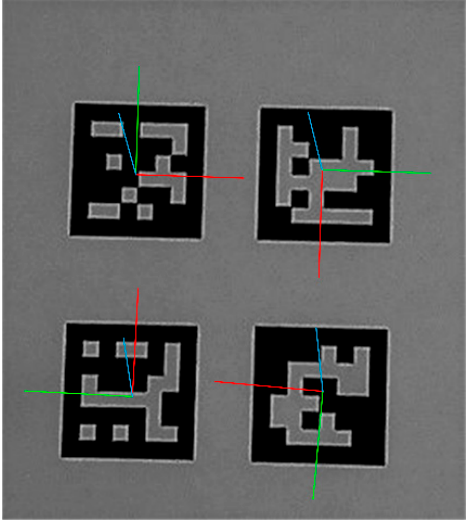
Figure 22. ArUco markers close range detection.